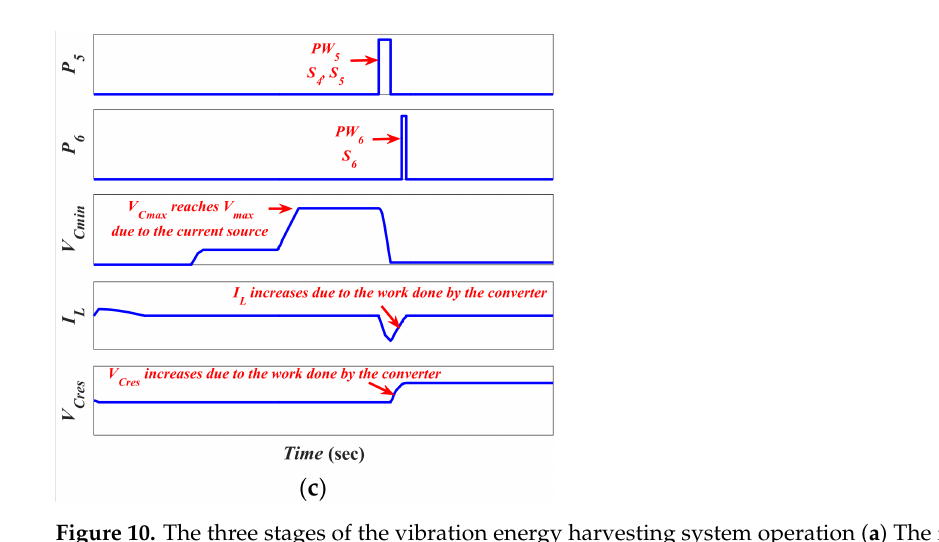
Figure 10. The three stages of the vibration energy harvesting system operation ( a ) The first stage, ( b ) The second stage, and ( c ) The third